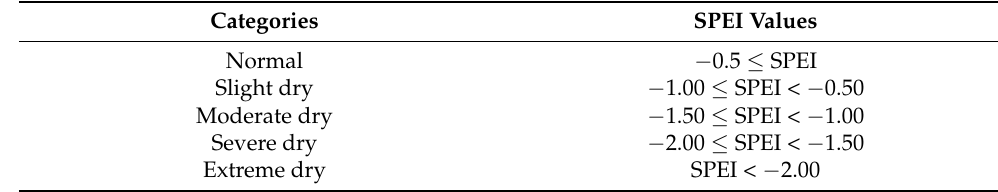
Table 2. Categories of the drought based on the